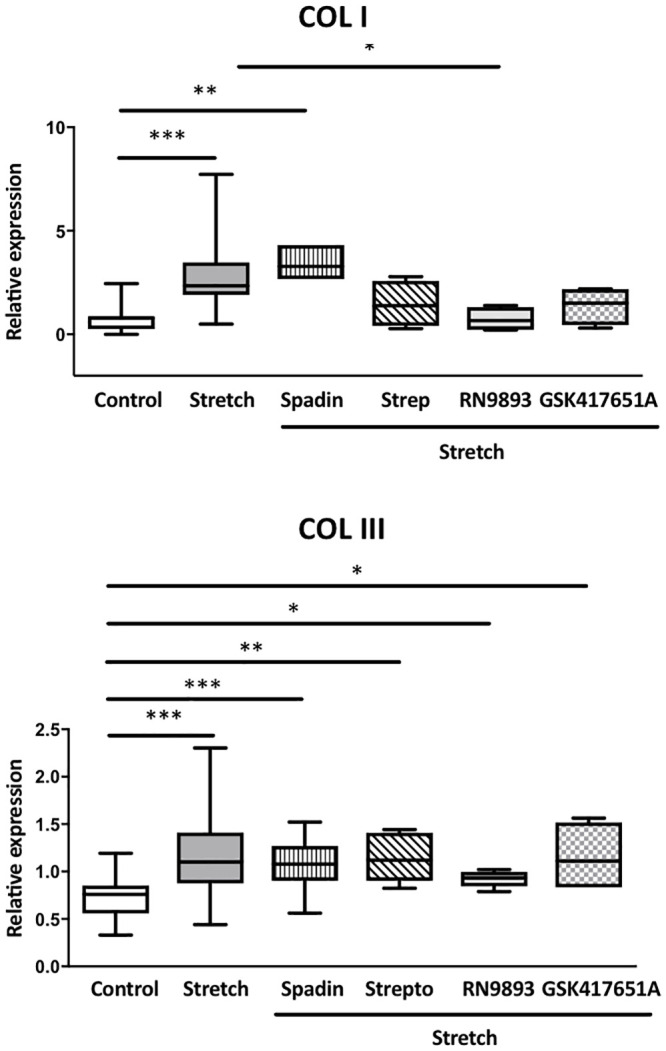
Role of TREK-1, TRPV4 and TRPC6/3 channels in stretch-induced changes in collagen mRNA expression in VICFB.Changes in mRNA expression (relative to 18S) for COL I and COL III in VICFB under static conditions (white bars), after cyclic stretch (grey bars), and after stretch in the presence of either the TREK-1 channel inhibition by spadin, the general MSCNS blocker streptomycin, the TRPV4 inhibitor RN-9893 or the TRPC6/3 inhibitor GSK417651A (hatched bars) after 24 h of stretch. Gene expression was measured by RT-PCR and normalized to the housekeeping gene (n = 4 and 6 patients for COL I and III respectively; * = p<0.05, ** = p<0.01, *** = p<0.001).